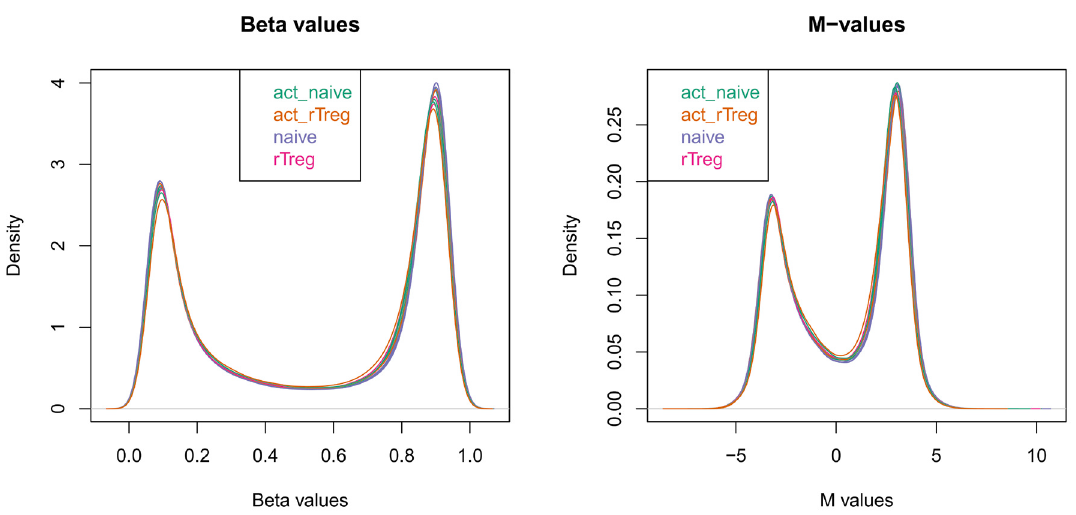
Figure 8. The distributions of beta and M-values are quite different; beta values are constrained between 0 and 1 whilst M-values range between -Inf and Inf.